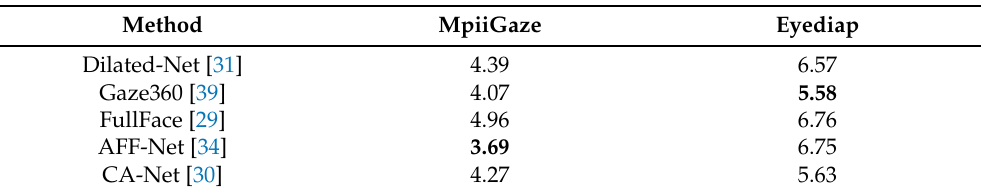
Table 2. Performance summary ( angular-error ) and comparison with recent works using eye and facial features.